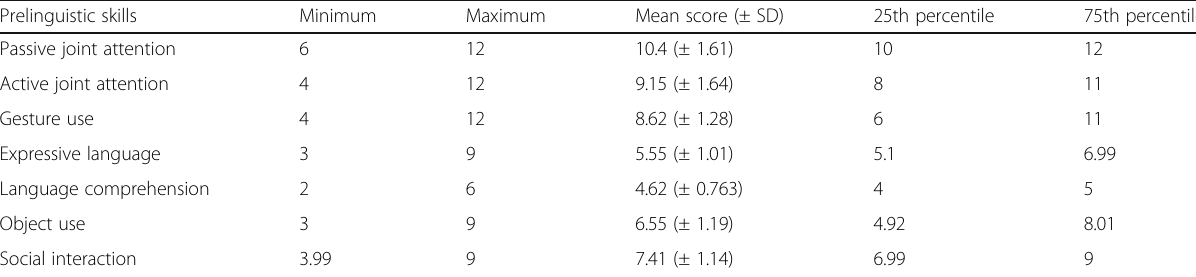
Table 6 The mean response of the whole studied sample in different prelinguistic skills Prelinguistic skills